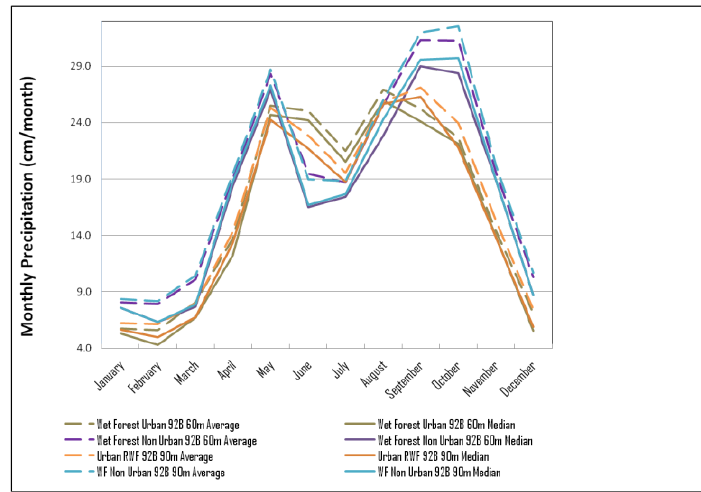
Figure 7. Average and median urban and non-urban monthly precipitation, Wet Forest.